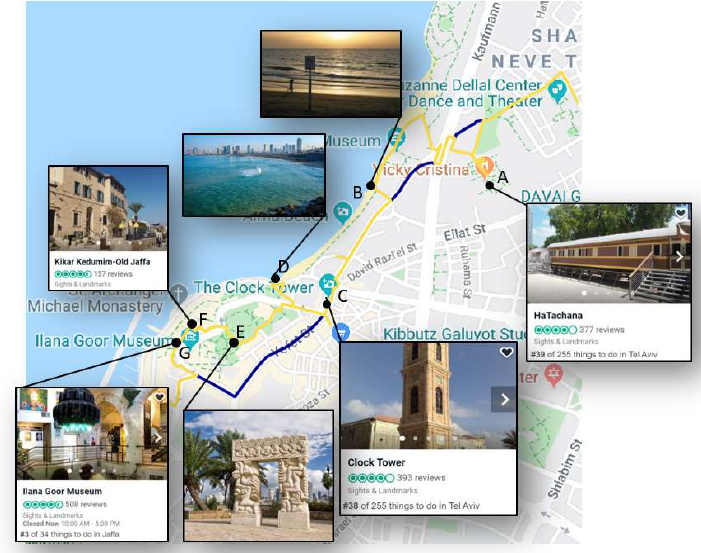
Figure 6. Tel-Aviv walking routes: tourism (yellow) and shortest (via Google Maps) (blue). Main traversed landmarks and attractions (with TripAdvisor ranking where exists): Mitcham-Ha’Tachana (A), the beach area (B), the Old Jaffa Clock Tower (C), a viewpoint from Old Jaffa (D), Habrasha Park (E), Kikar Kedumim (F), and the Ilana Goor Museum (G) (background: Google Maps).